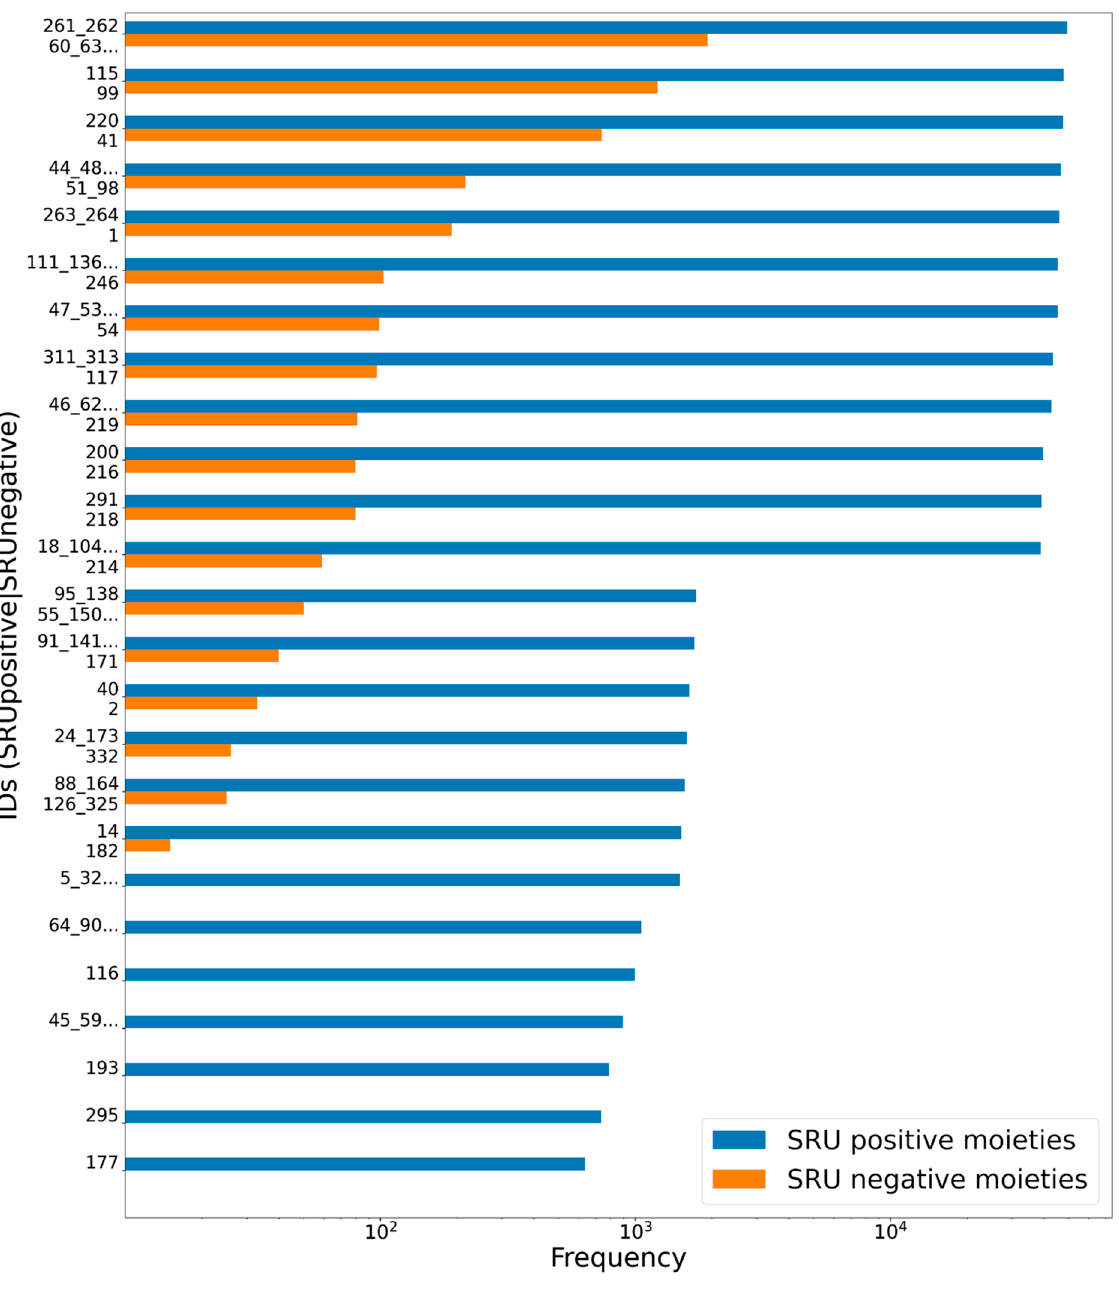
Figure 15. Frequencies of glycosidic moieties reported in bacterial NPs in COCONUT, grouped for detectability by the SRU after lowering the exocyclic oxygen ratio threshold setting to 0.3. Sugar moieties detectable by the SRU are denoted “SRU positive moieties” (blue bars), and the remaining are denoted “SRU negative moieties” (orange bars). The ID on the vertical axis refers to the identifiers used in the original publication of the dataset, concatenated where stereoisomers were grouped. Frequencies, as detected by substructure matching, are in log-scale. Only moieties with at least ten matches in COCONUT were considered and out of these, the 25 most frequent are listed, respectively.